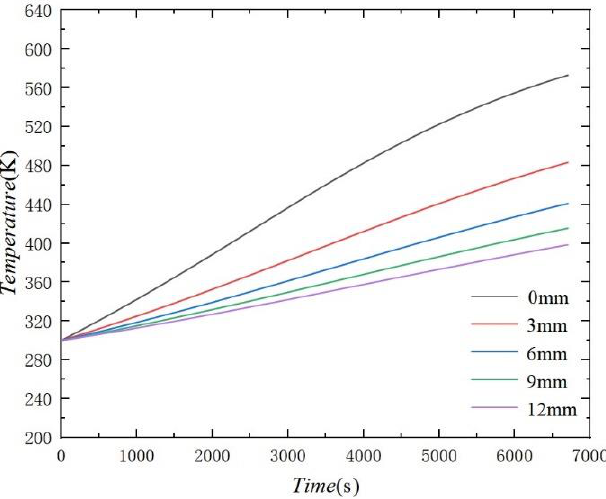
Figure 12. Temperature of accessory 2 when adding heat insulation layers of different thicknesses to the casing.